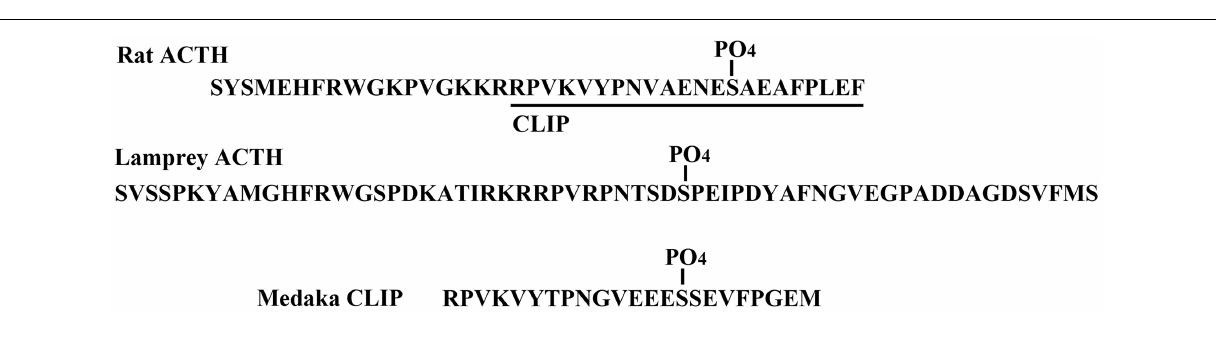
FIGURE 2 | Phosphorylation ofACTH and CLIP molecules in the pituitary